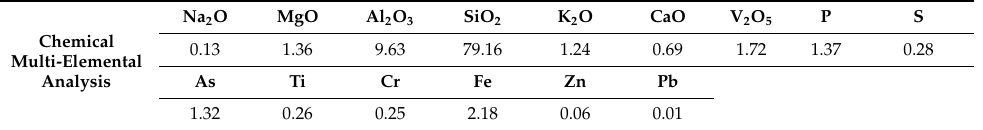
Table 1. Chemical multi-elemental analysis of siliceous shale (wt %).